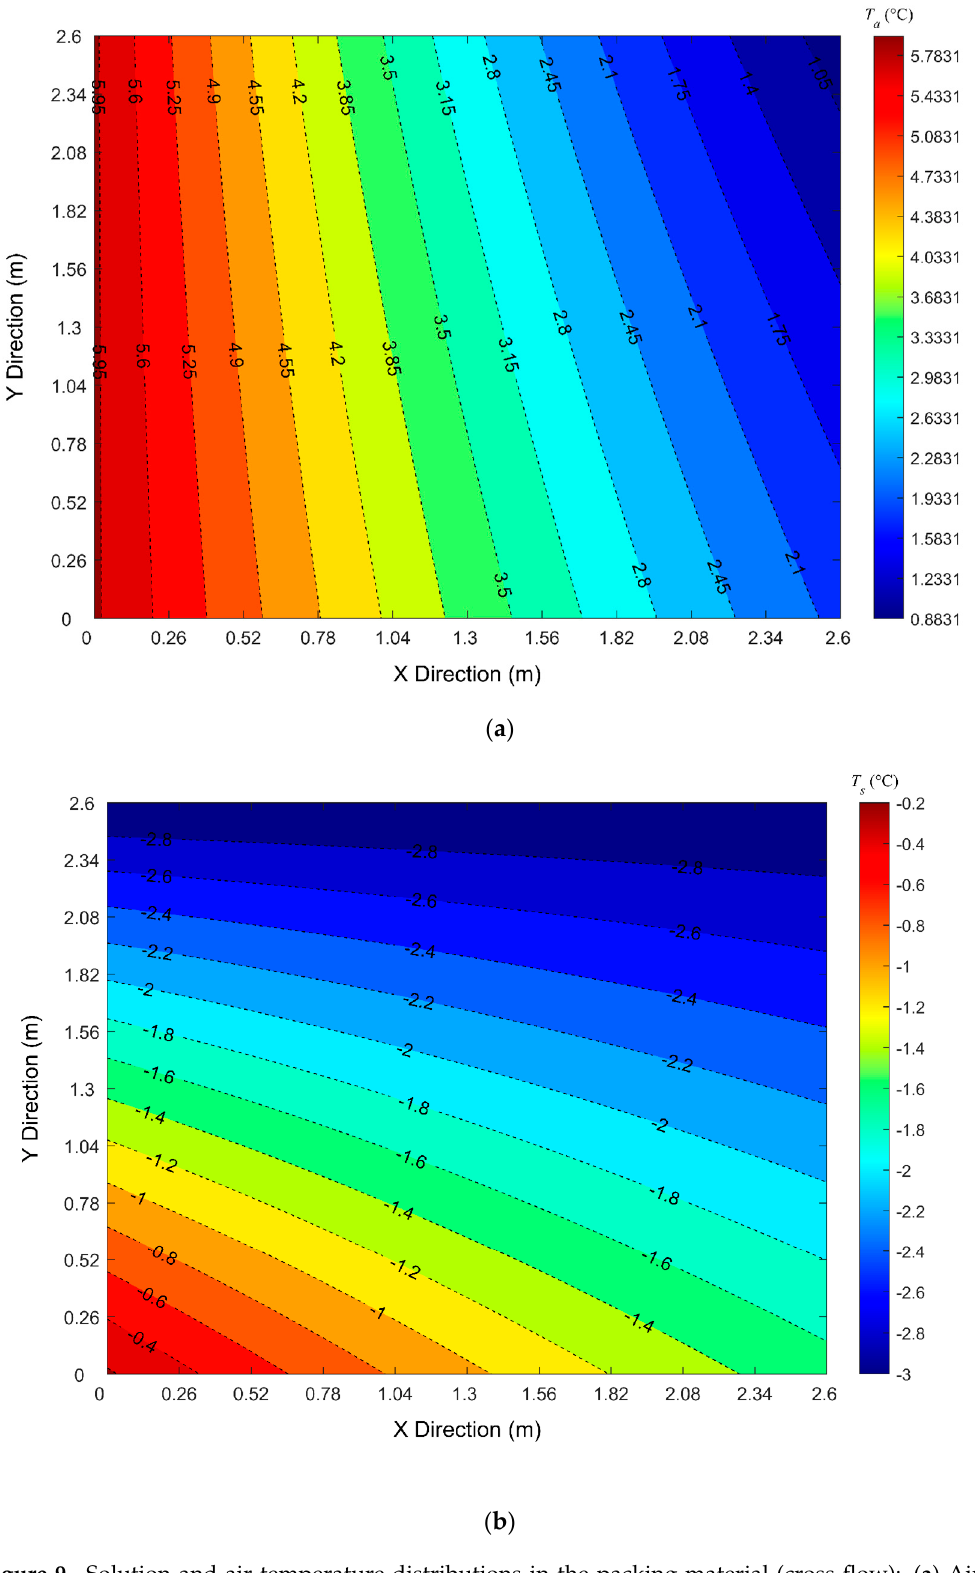
Figure 9. Solution and air temperature distributions in the packing material (cross-flow): ( a ) Air temperature; ( b ) Solution temperature.